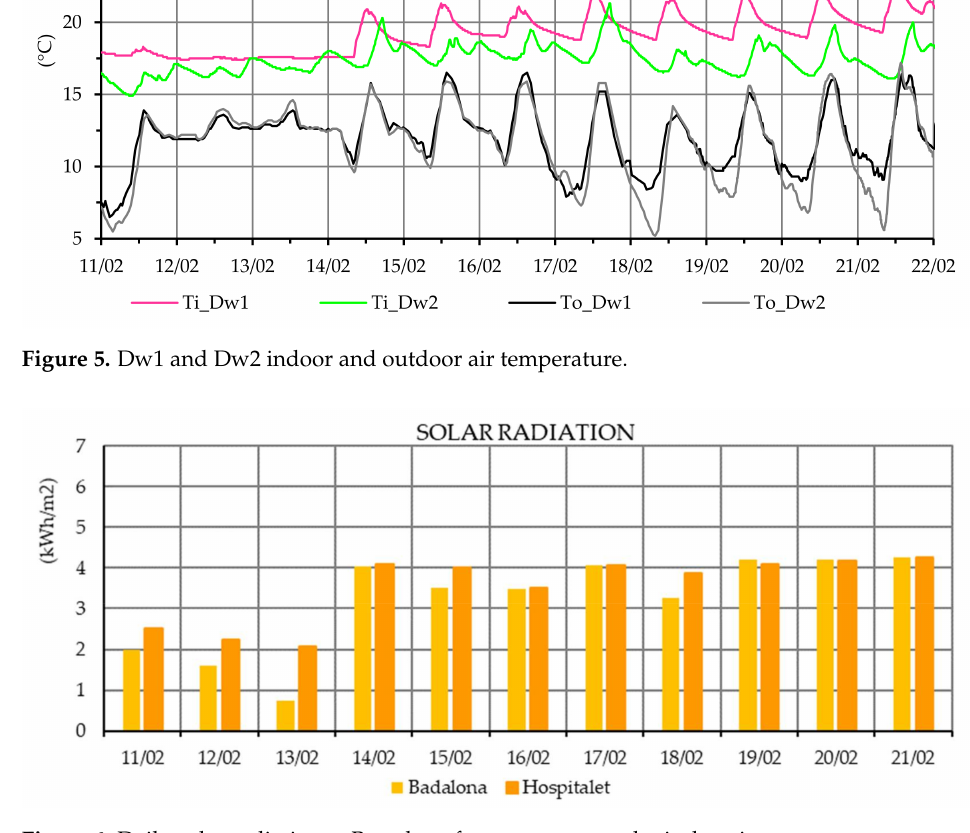
Figure 6. Daily solar radiation at Barcelona from two meteorological